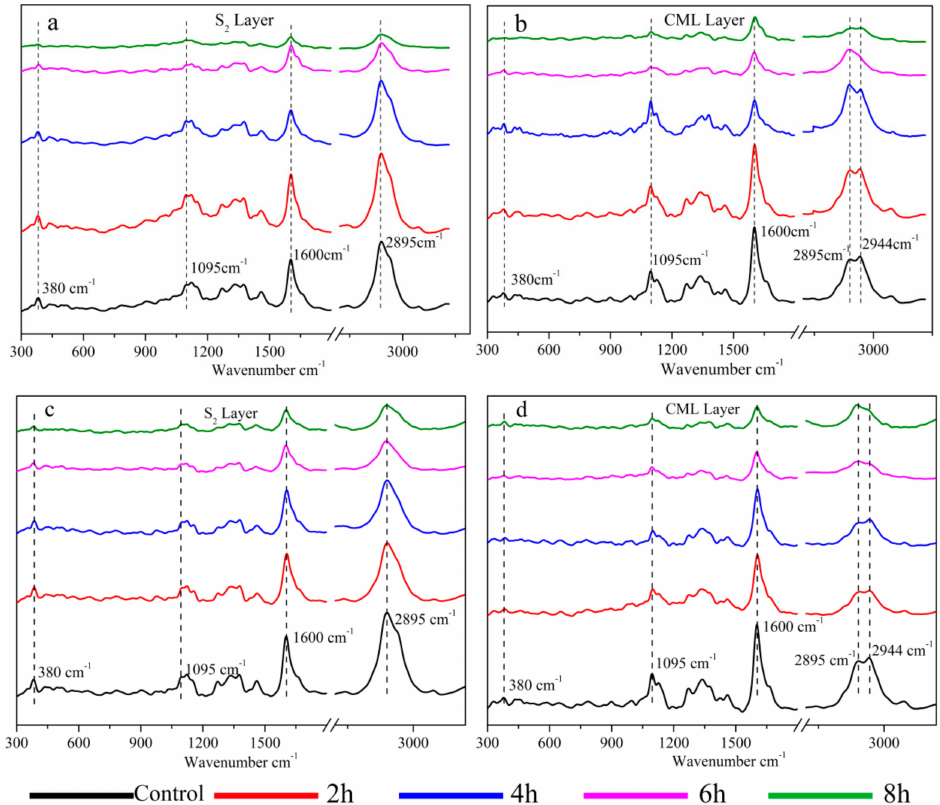
Figure 2. Change in chemical structure with di ff erent acid (( a ): S 2 , ( b ): compound middle lamella (CML)) and alkali (( c ): S 2 , ( d ): CML) treatment.